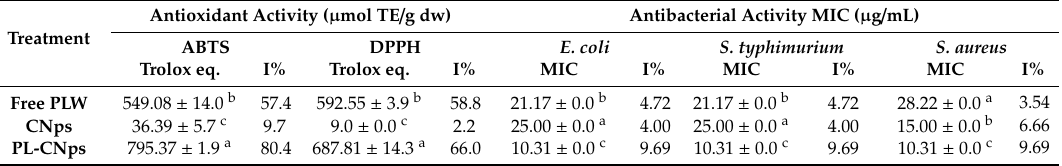
Table 3. Biological activity of phenol-loaded chitosan nanoparticles (PL-CNps), free PLW extract and chitosan nanoparticles